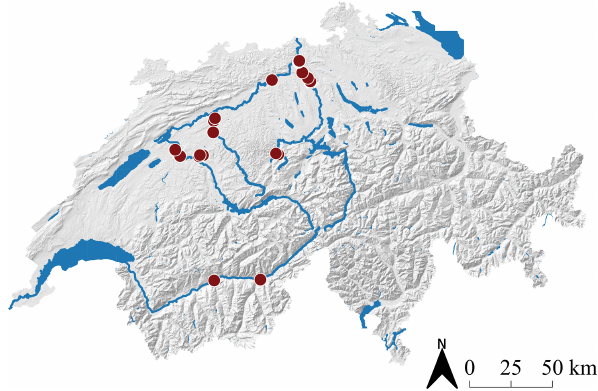
Figure 2. Overview map with the 25 ground truth locations of the investigated gravel bars in